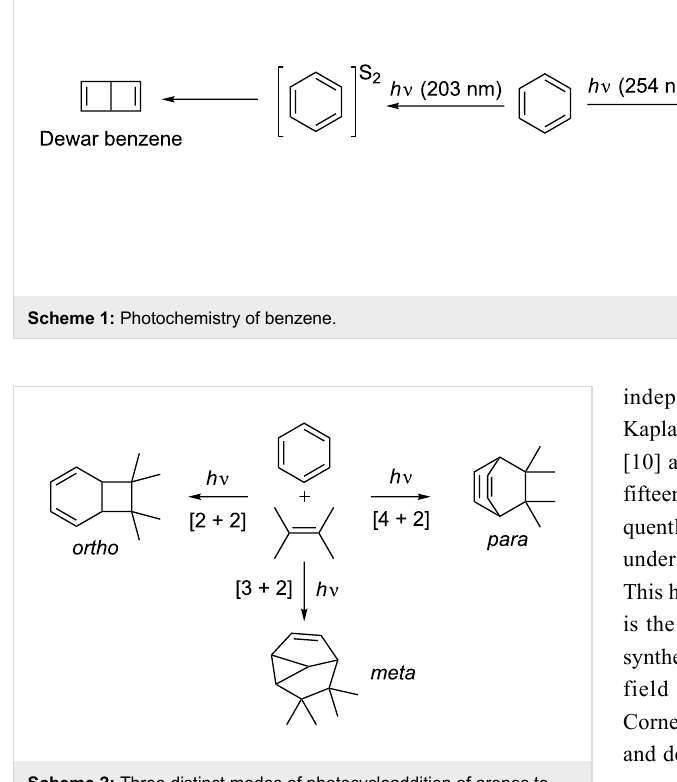
Scheme 2: Three distinct modes of photocycloaddition of arenes to